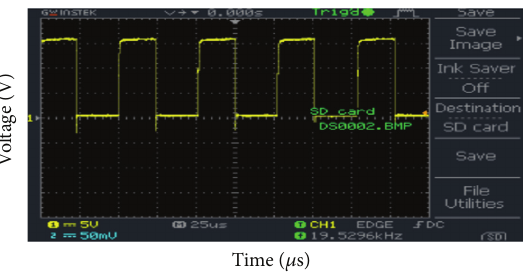
Figure 12: Gate emitter voltage of IGBT.